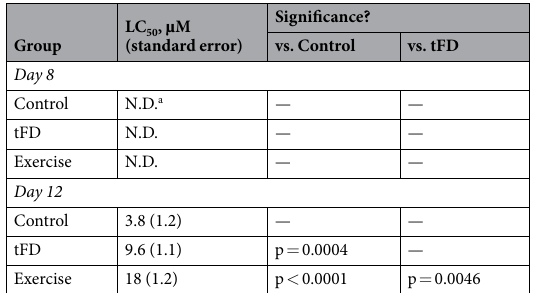
Table 2. LC 50 values after 24-hour exposure to rotenone. Animals were subjected to twice-daily 90 min swim exercise beginning at young adult and continuing for 6 days. Lethality was tested on day 8 (the day after ceasing swim exercise) and on day 12. Significance was determined by pairwise comparison of the nonlinear LC 50 fits using the extra sum-of-squares F test. a Rotenone did not cause significant lethality on day 8 at highest soluble concentrations (see Fig. 4c); therefore, LC 50 values could not be calculated.